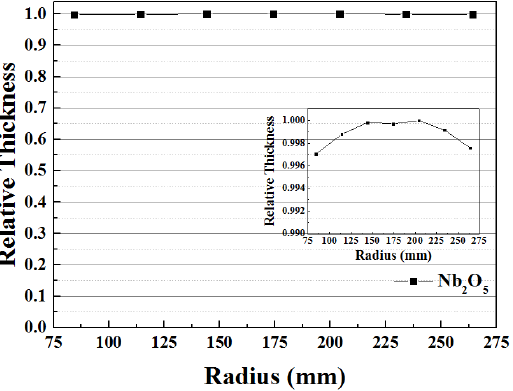
Figure 11. Relative thickness of Nb 2 O 5 thin film deposited on a large substrate with a radius of 275